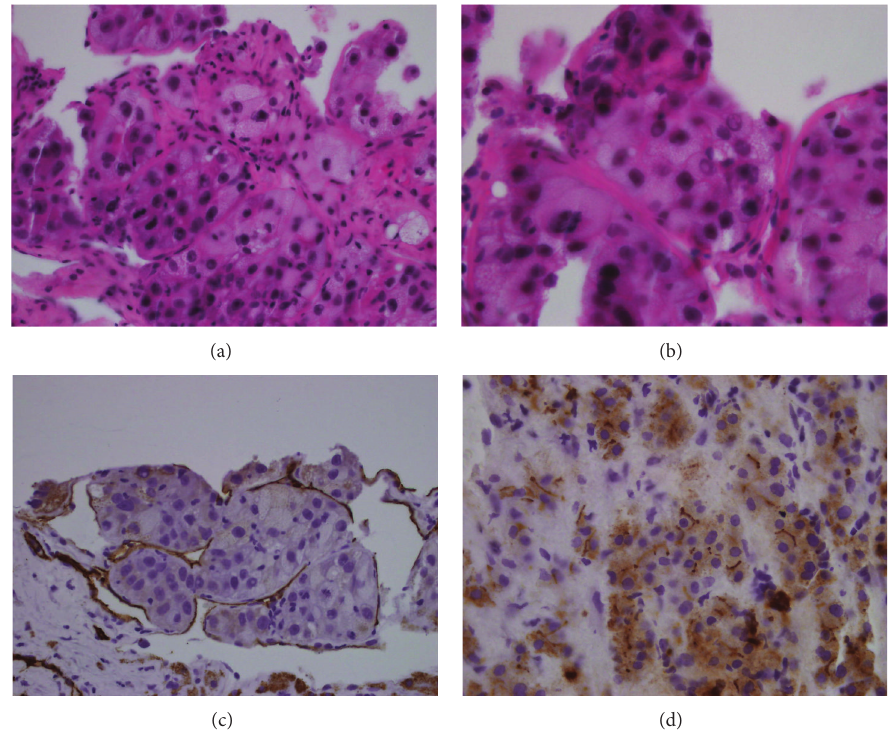
Figure 4: Liver biopsy. Hematoxylin and eosin staining (a) and (b). Immunostaining for CD34 (c) and for carcinoembryonic antigen (CEA)